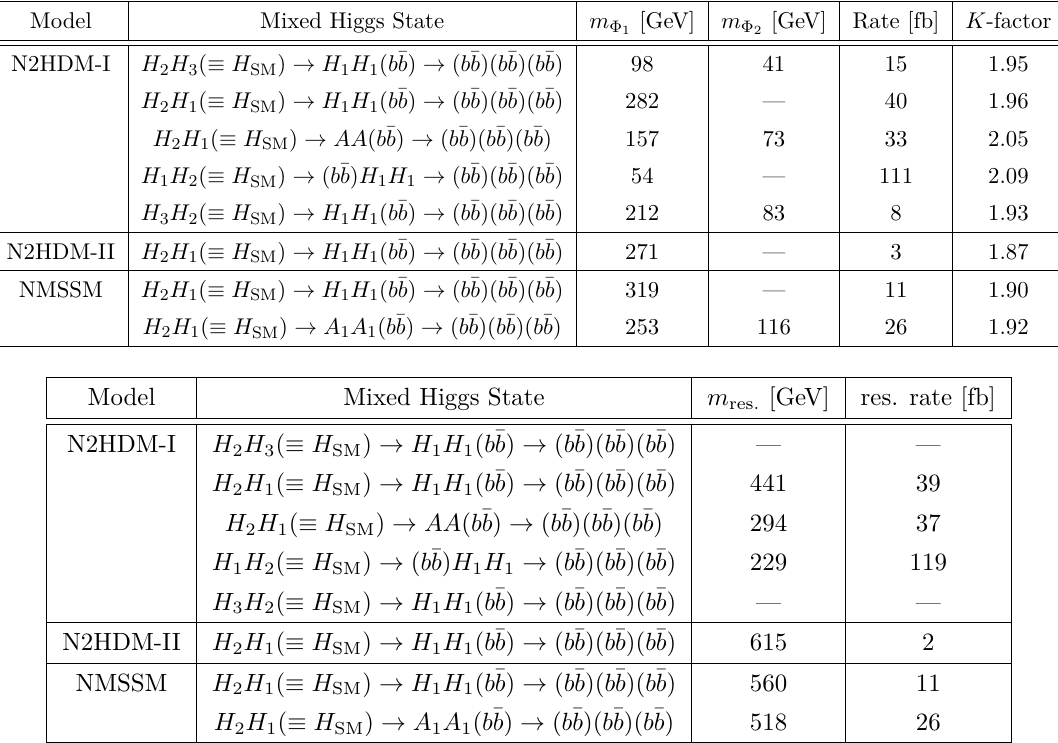
Table 31 . Upper: maximum rates for multi-Higgs final states given at NLO QCD. The K -factor is